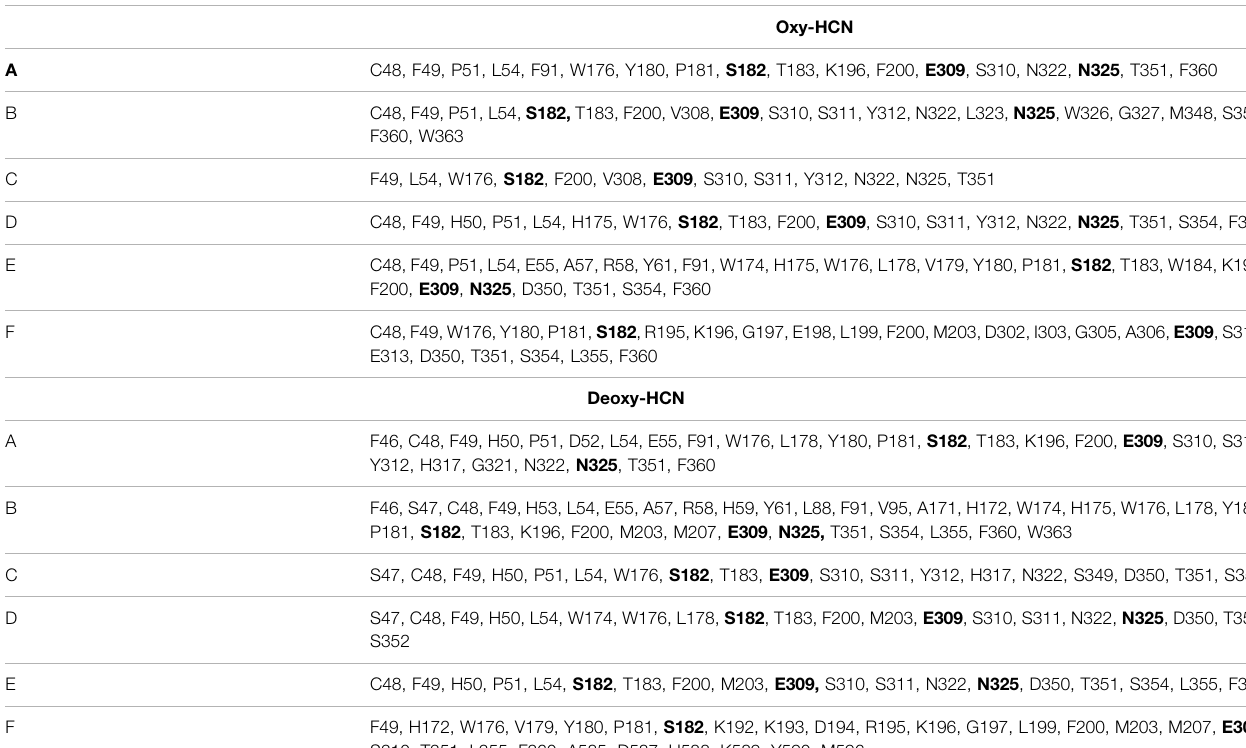
TABLE 2 | Tunnel lining residues of the tunnel cluster with the highest average throughput and average bottleneck